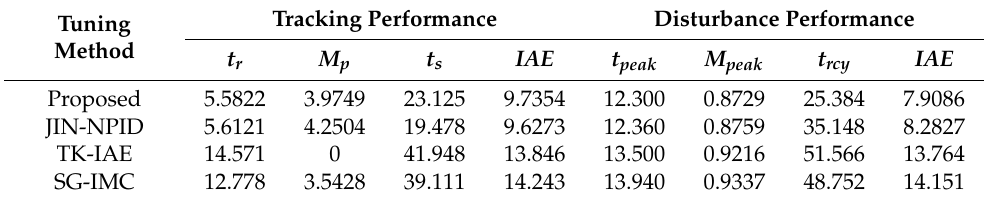
Figure 11. Servo and regulatory responses for nominal process 3. Table 8. Quantitative comparison of performances for nominal process 3. Table 8. Quantitative comparison of performances for nominal process 3. Tuning